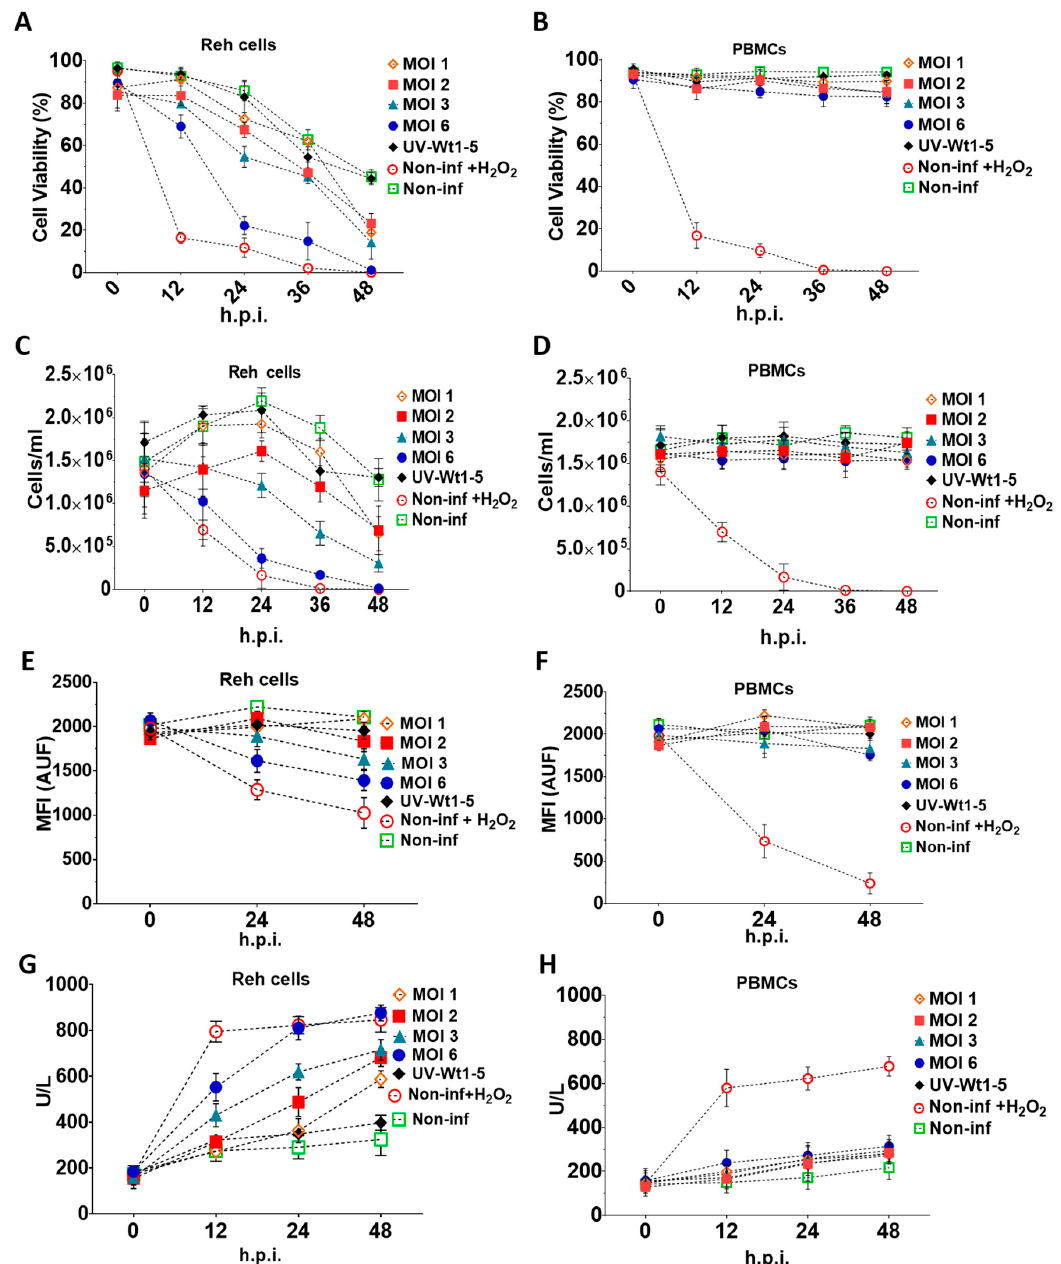
Figure 2. Effects of Wt1-5 infection of Reh cells and PBMCs on cell viability and cell membrane permeability. Reh cells at a logarithmic growth phase and PBMCs were inoculated with trypsin-activated Wt1-5 (MOI 1 to 6) in RPMI culture medium without FBS. Non-infected cells, UV-inactivated virus-infected cells at MOI 2, and non-infected and H 2 O 2 -treated cells were used as a control. Infected Reh cells ( A ) and PBMCs ( B ) were harvested at the indicated post-infection times (h.p.i.) and subjected to the trypan exclusion test. Reh Cells ( C ) and PBMCs ( D ) were collected at the post-infection times indicated and the viable cells counted in a Neubauer chamber and expressed as cells / mL. Cell proliferation analysis of Reh cells ( E ) and PBMCs ( F ) infected or not infected with Wt1-5 (MOIs 1 to 6), using CellTracker ™ Blue CMAC Dye. Quantification is expressed in terms of arbitrary fluorescence units (AUF) through the post-infection period indicated. Cell membrane permeability of Reh Cells ( G ) and PBMCs ( H ) was determined at the indicated post-infection times by measuring lactate dehydrogenase (LDH) activity in the 700 g supernatant of infected, non-infected and UV-inactivated virus-infected cells cultured in RPMI culture medium without FBS. Data are shown as mean SD of three independent experiments performed in